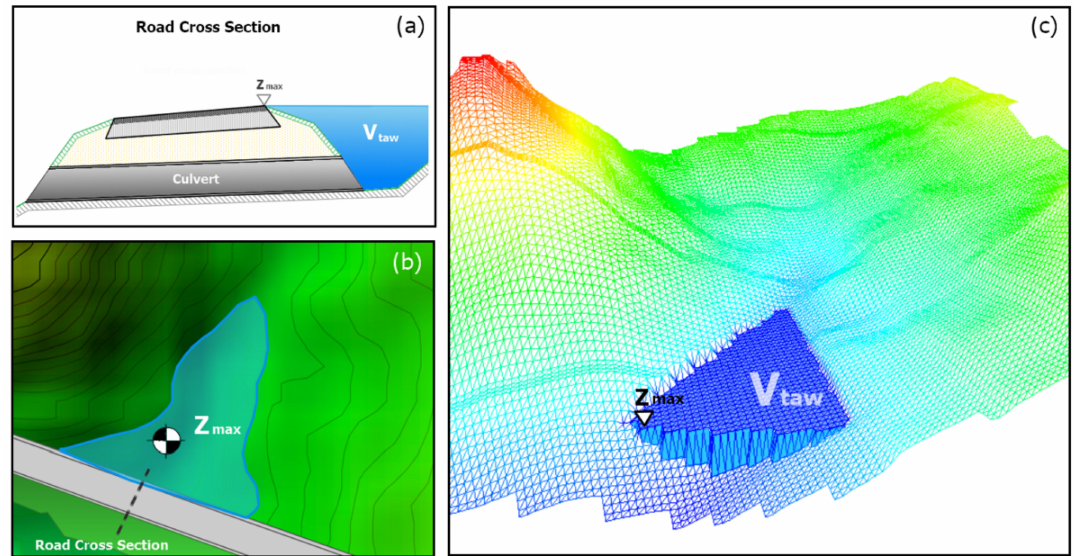
Figure 3. Determination of the volume of temporarily accumulated water: ( a ) cross section of the road with culvert, ( b ) layout of the surface area under accumulated water for Z max and ( c ) view of triangulated irregular network for determination of V taw